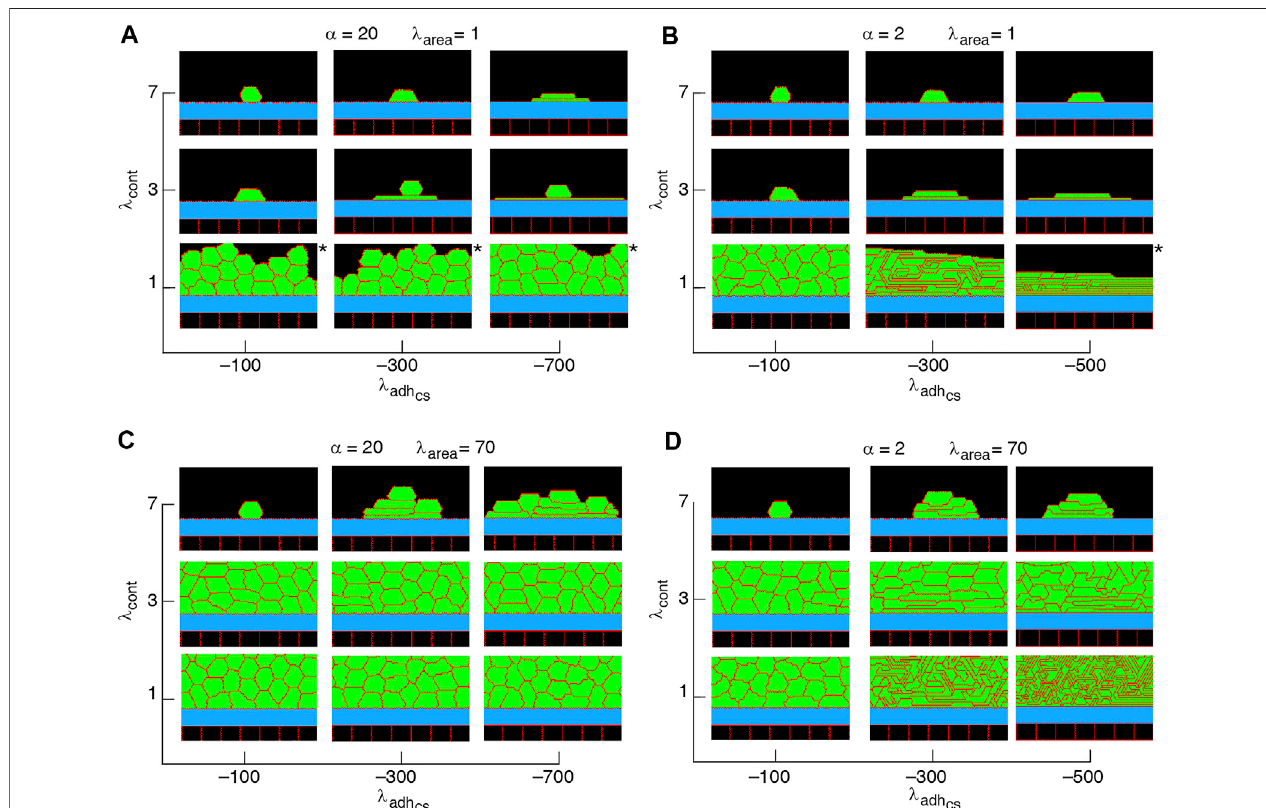
FIGURE6| Phasediagram ofcollective cell morphologywithhorizontal orientationofcell proliferation, where the axis ofdivision isparallel tothe substrate, i.e., n div = (0, 1); see Eq. 3 (A – D) . α (cid:1) λ adh / λ adh . *Slow-growing multilayers. See Supplementary Movies S6, S7 . cs cc